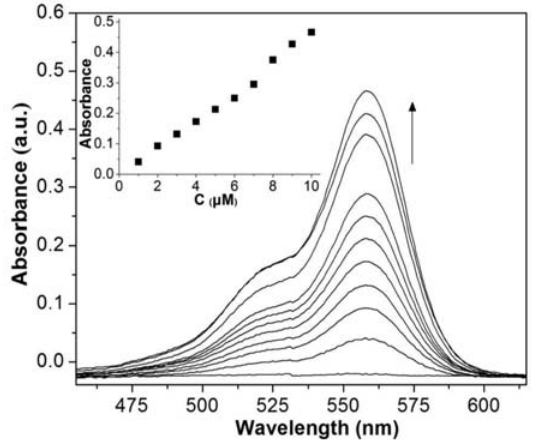
Figure 6. UV-vis spectra of RD (10 μM) in the presence of diffe- rent concentrations of Hg 2+ (0–10 μM) in MeCN-H tion. Inset: absorbance as a function of Hg 2+